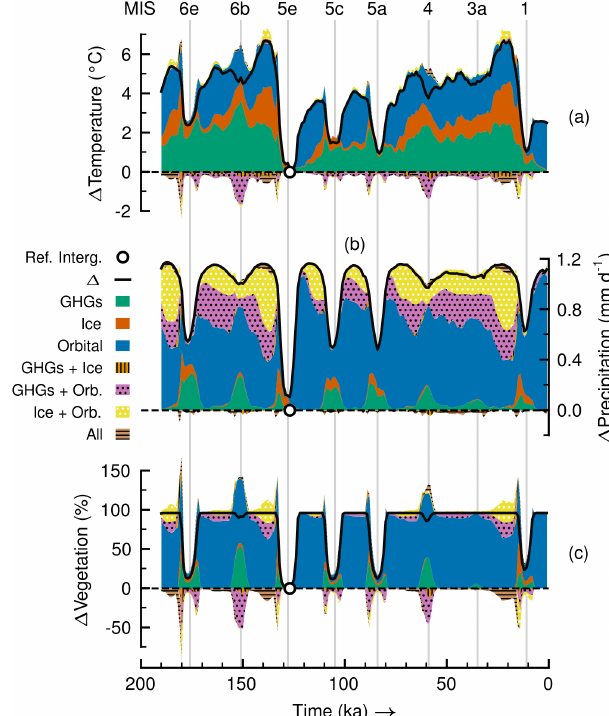
Figure 5. Factor separation analysis in the Sahara grid box from an interglacial perspective for annual means of (a) near-surface tem- perature, (b) precipitation and (c) vegetation cover fraction. Colours indicate contributions from individual forcings and related syner- gies to the total deviation in EI7 (Eemian-like AHP) from the con- trol experiment ( (cid:49) = EI7 − E0). Synergies are also shown with pat- terns. A marker shows the location of the reference interglacial state, where the difference between EI7 and E0 is minimal. Ver- tical lines indicate maxima of the monsoon forcing index and are labelled using MIS names on